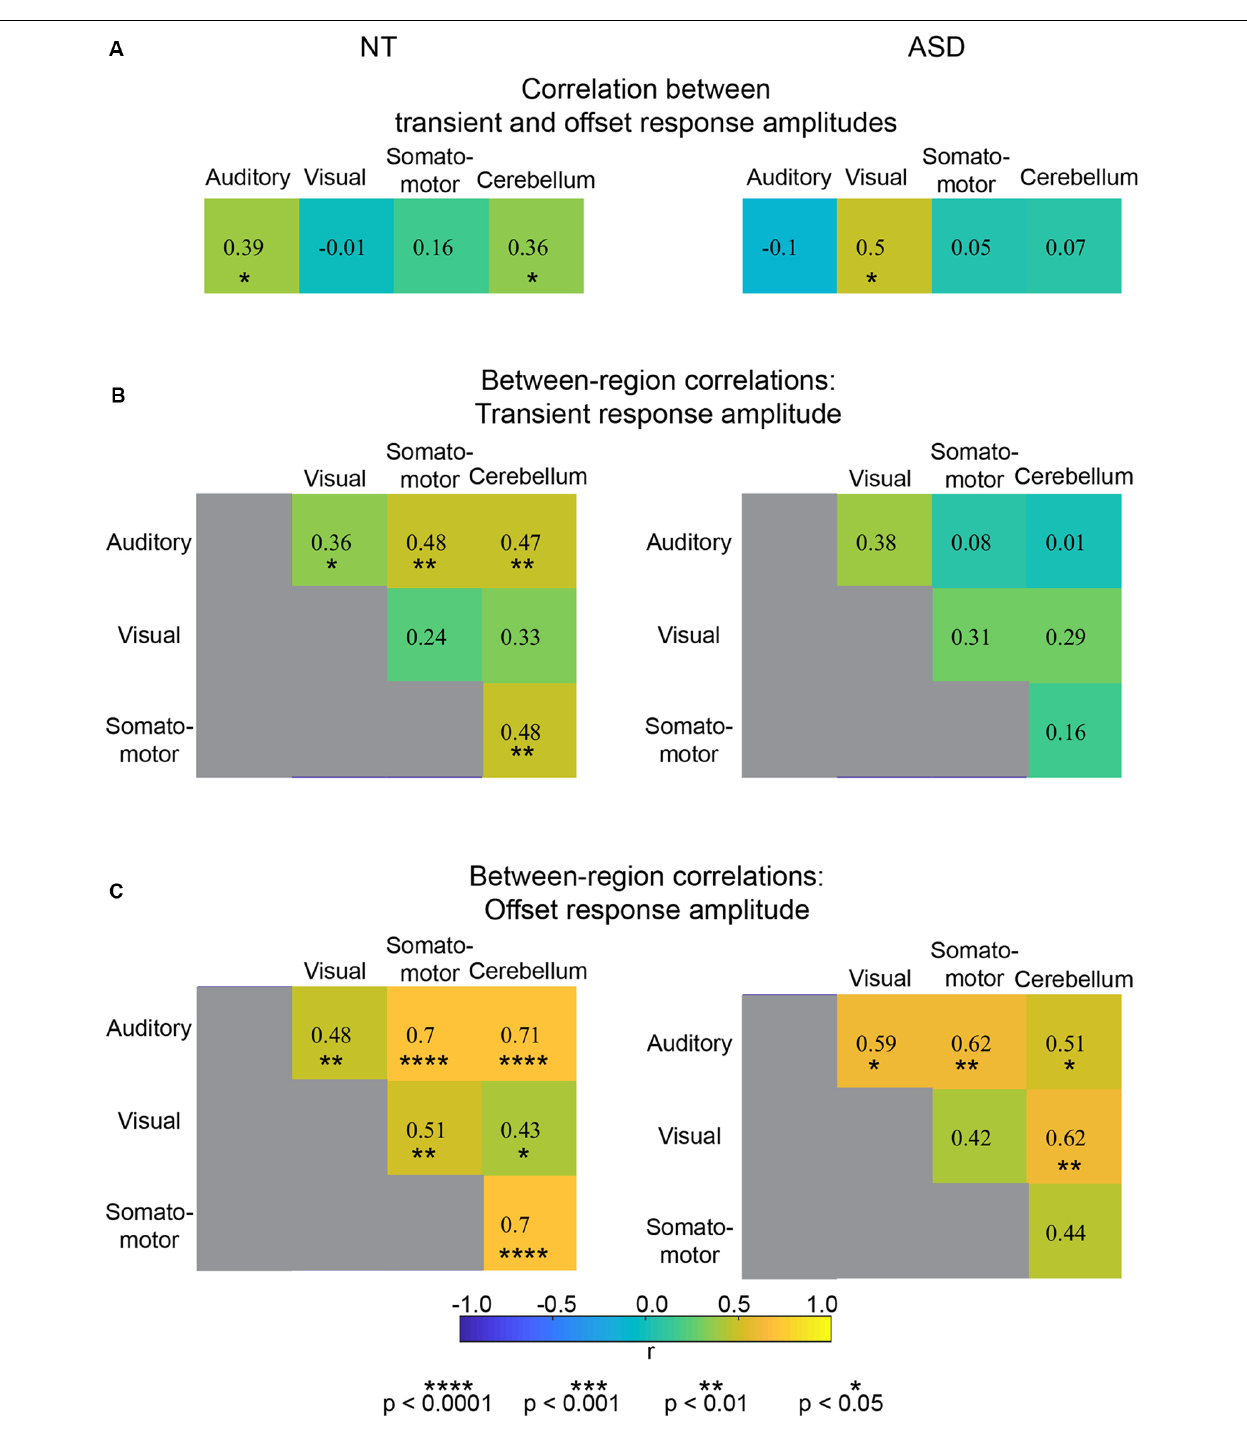
FIGURE 3 | (A) Correlation values for individual differences in transient and offset amplitude within four ROIs. (B) Correlation values for between-region individual differences in transient response amplitude. (C) Correlation values for between-region individual differences in offset response amplitude.